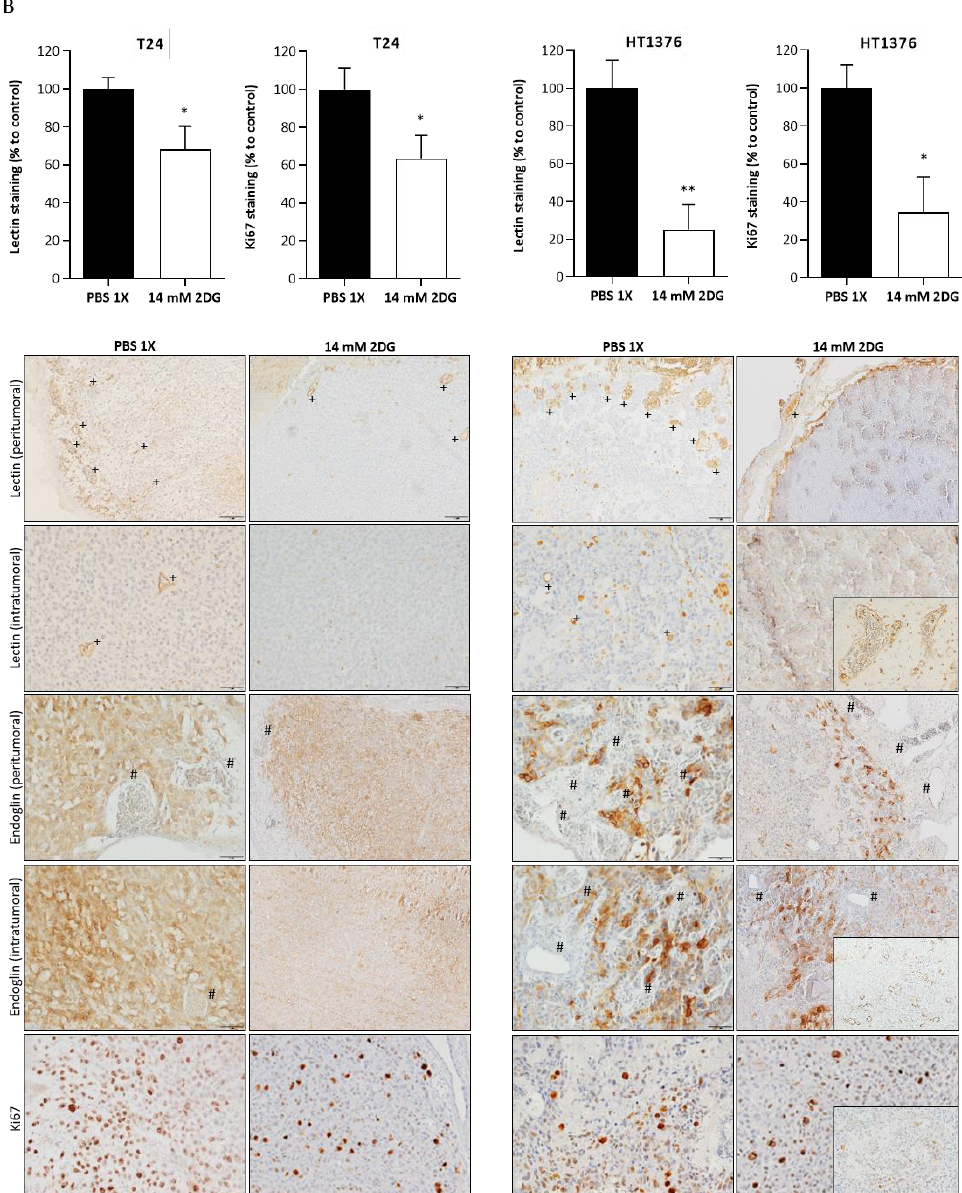
Figure 9. Effect of 2DG on tumour growth and angiogenesis of T24 and HT1376 urothelial bladder carcinoma cell lines “in vivo”, detected by the chicken chorioallantoic membrane (CAM) assay at 96 h post-treatment. In ( A ), quantification of tumour growth and blood vessel formation is shown, followed by representative images at 13th (“in ovo”— start of treatment) and 17th (“in ovo” and “ex ovo”— end of treatment) days post egg incubation (4th and 8th days post cell injection, respectively) of the control (PBS 1×) and treated (2DG 2×IC 50 ) conditions. In ( B ), quantification of the percentage of lectin and Ki67 immunoreactive cells is depicted, followed by representative images of the excised CAM tissue sections of the control (PBS 1×) and treated (2DG 2×IC 50 ) conditions, immunostained for lectin, endoglin, and Ki67. Positive immunoreactions for lectin in peritumoural and intratumoural blood vessels (+), endoglin in peritumoural and intratumoural malignant cells (negative blood vessels are indicated by # ), and Ki67 in malignant cell nuclei are shown. Positive controls in insets (lectin: CAM section with known positivity; endoglin: oral squamous cell carcinoma; Ki67: lymphoma). Original magnifications of 100 or 200x. Results are expressed as the mean (normalized in ( B )) ± SEM of one experiment. * p < 0.05, ** p < 0.01 and **** p < 0.0001 for 2DG 2×IC 50 versus control condition (PBS 1×).